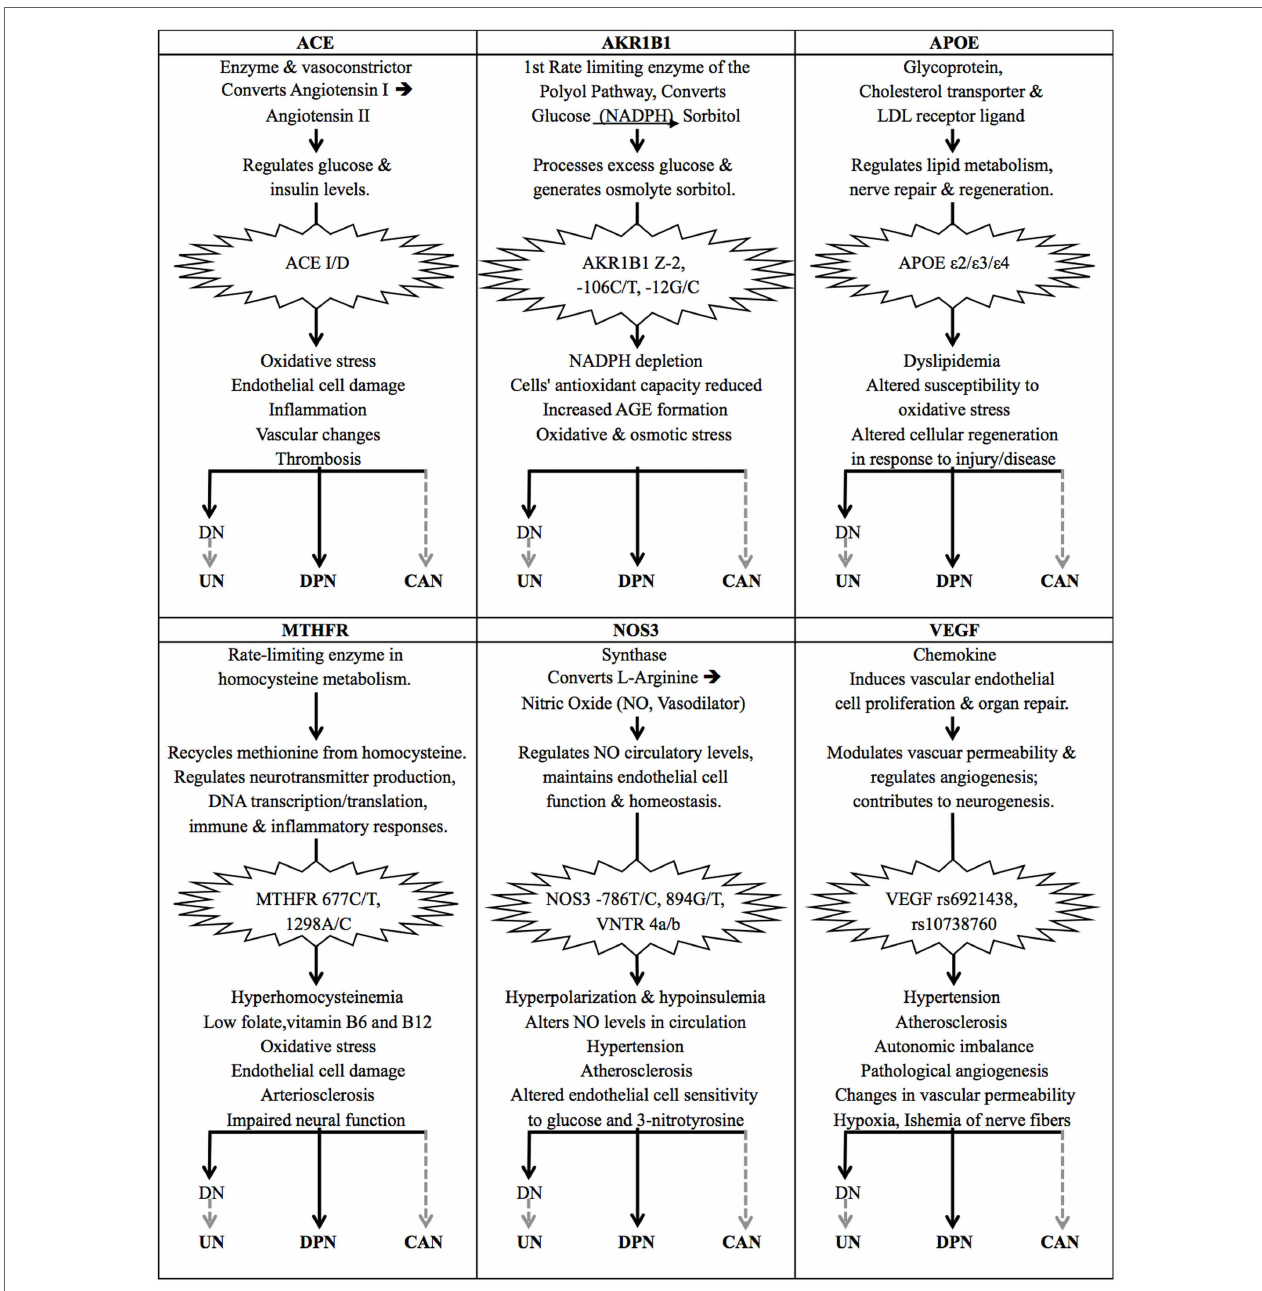
thought to lead to uremic neuropathy (UN), suggesting that these genetic risk factors also affect the onset and progression of UN. The same genetic variants have also been implied in diabetic autonomic neuropathy and cardiac complications, suggesting their involvement in CAN, but their direct association with CAN in T2DM patients remains to be proven. Solid black arrows indicate that a statistically significant association has been published; dashed gray arrows indicate a suspected